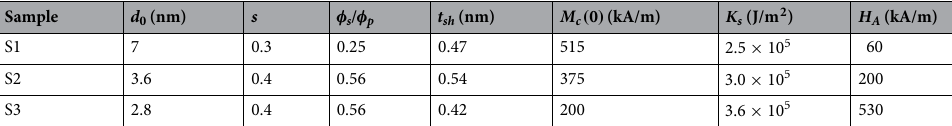
Table 1. Core/shell and magnetic characteristics of NPs samples. d 0 is the median diameter, s the polydispersity index, φ s /φ p the volume fraction of the maghemite shell, t sh its thickness, M c ( 0 ) the core magnetization at T = 0 K, K s the surface anisotropy constant of the maghemite shell and H A the anisotropy